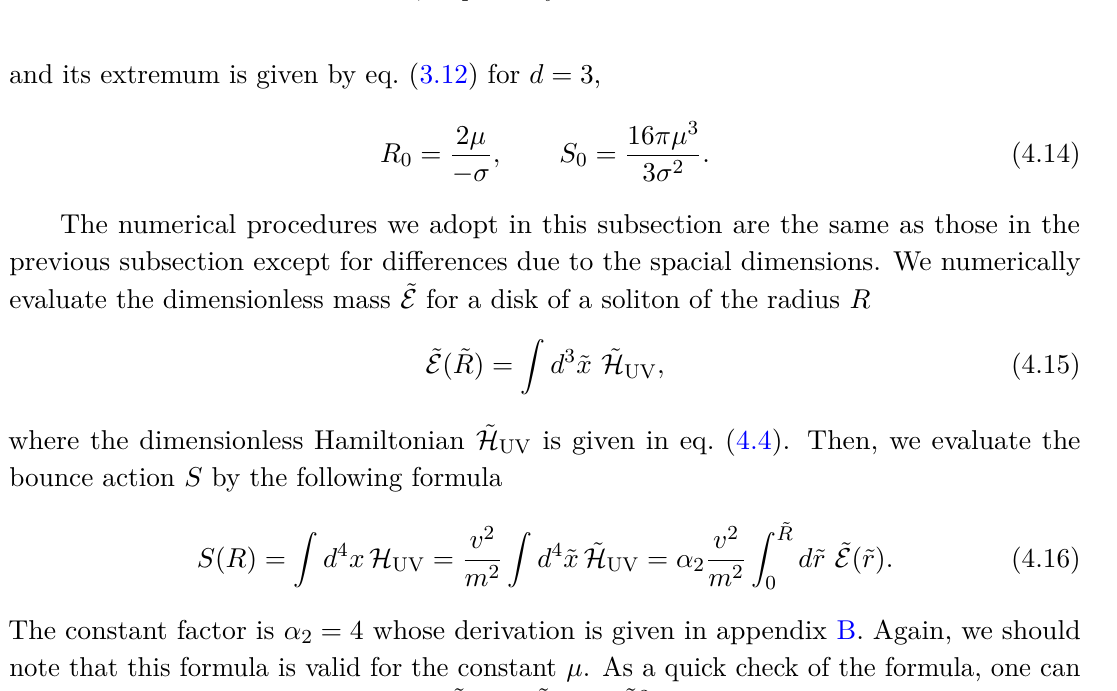
Figure 4 . The three-dimensional disk soliton perpendicular to the z -axis generated from the two-dimensional linear soliton. In the left panel the red part shows the region for | ˜ φ | < 0 . 9 , and the blurred-blue part corresponds to the region for Re[˜ φ ] < 0 . 4 . The middle and right panels show −| ˜ φ | on the ˜ x = 0 and ˜ z = 0 cross sections,